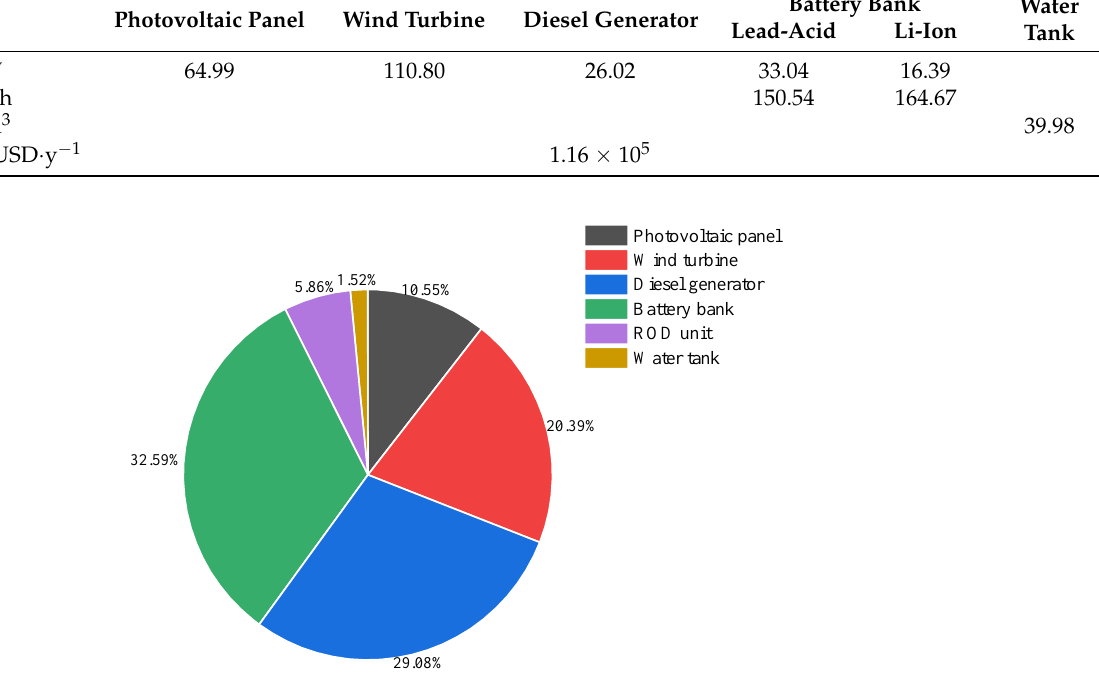
Figure 4. Cost compositions of the system.